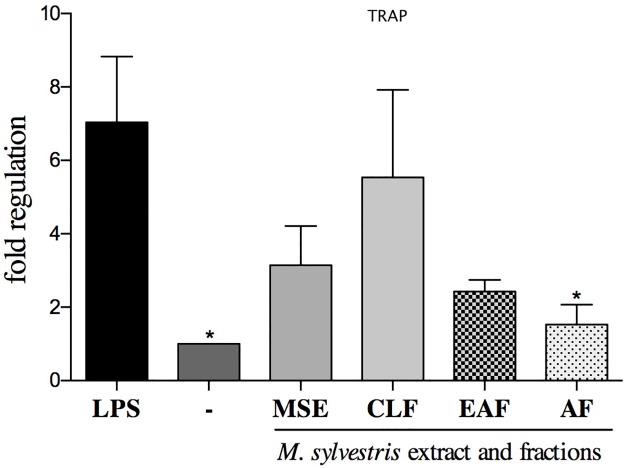
MSE and fractions effect on TRAP (tartrate-resistant acid phosphatase) expression levels.Quantification of the relative transcript amounts performed by qpcR with 10 ng of each cDNA. Data quantification was performed using 2(-DeltaDeltaC(T)). Statistical analyses were performed by one-way ANOVA followed by Dunnett’s post-hoc tests. *p < 0.05 significantly different from LPS-stimulated cells.